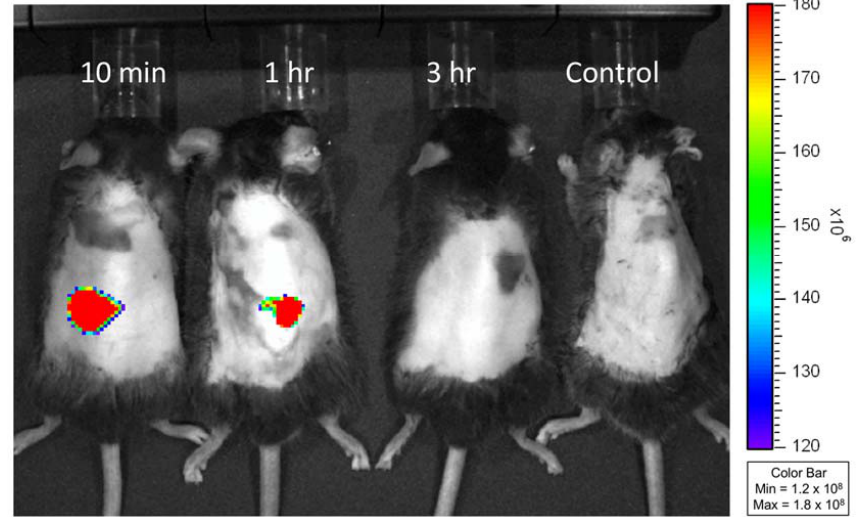
Figure 4. In vivo fluorescence images of db/db mice at 10 min, 1 h and 3 h after treatment of FITC-insulin-loaded gelatin/CMC MN patches and unloaded (control) MN patches. The insertion sites of mice dorsal skin presented a strong fluorescent signal at 10 min indicating that the dissolving MNs rapidly released encapsulated FITC-insulin. The fluorescence intensity decreased at 1 h and disappeared at 3 h after application of MN patches.